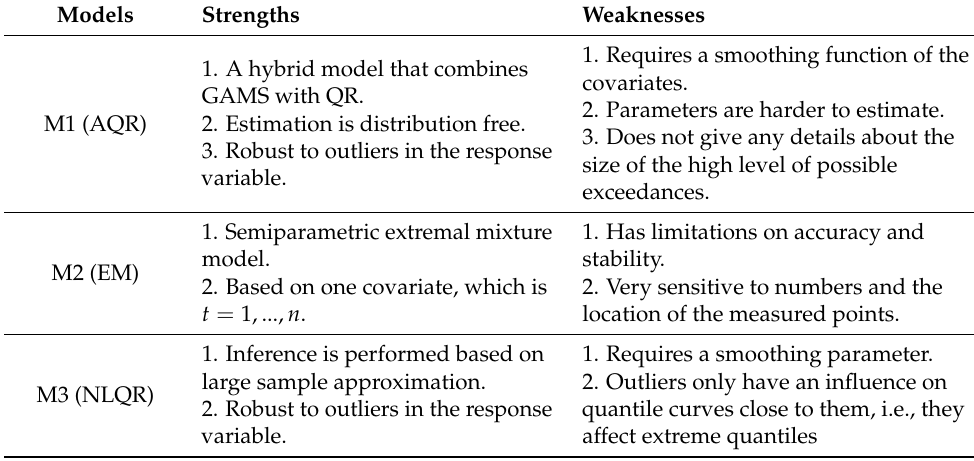
Table 2. Comparison of the